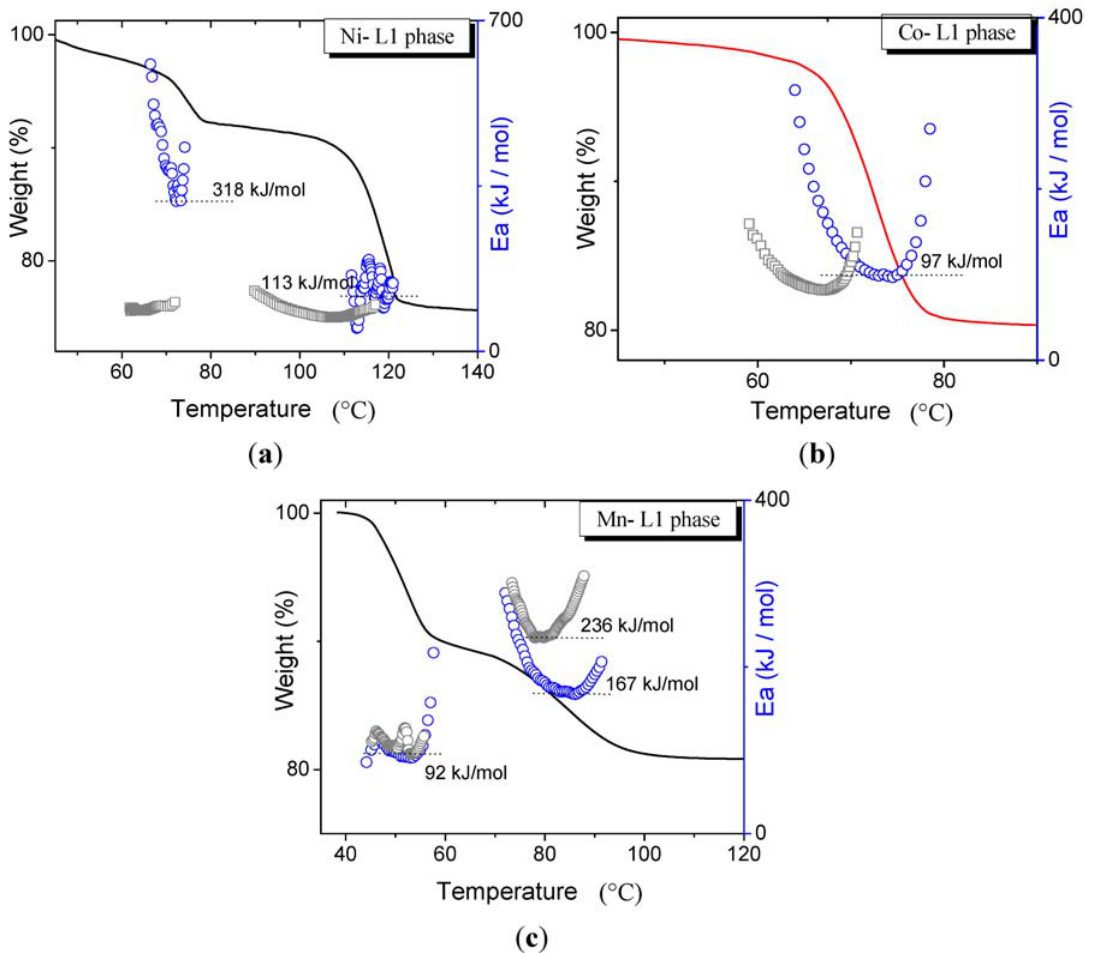
Figure 6. Thermogravimetric curves and the activation energy profiles for the three L O) [Ni(CN) ]·2H O, where M = ( a ) Ni 2+ ; ( b ) Co 2+ and ( c ) Mn 2+ ). Gray points in (M(H 2 2 4 2 each of the plots correspond to activation energy profiles of the L heating of the L 0